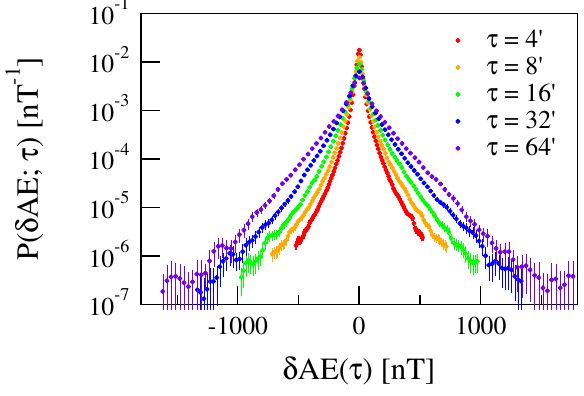
Fig. 1. The PDFs P(δ AE ; τ) of the AE index increments δ AE (τ) Fig. 1. The PDFs P ( δAE ; τ ) of the AE index increments δAE ( τ ) for τ = 4 , 8 ,..., 64 min. for τ = 4 , 8 ,...,